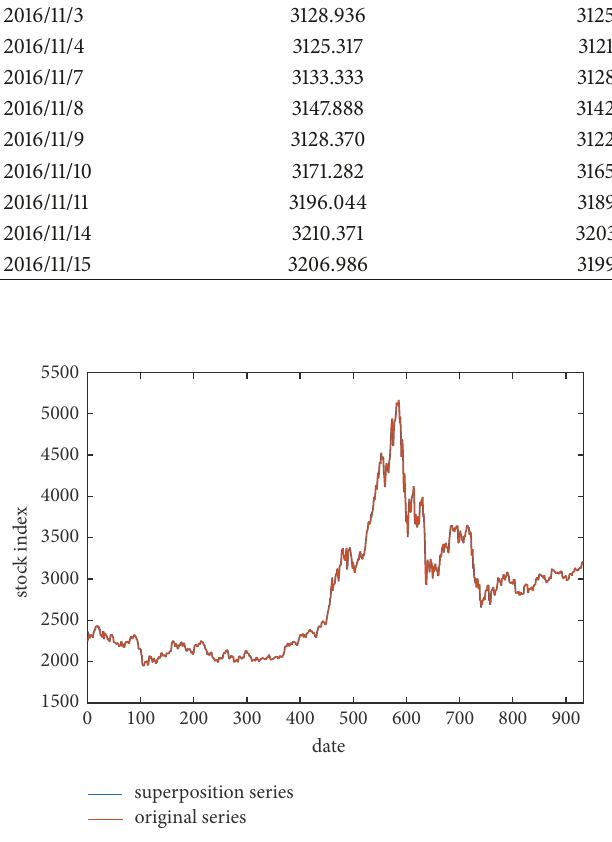
Figure 9: Superimposed series and original series.